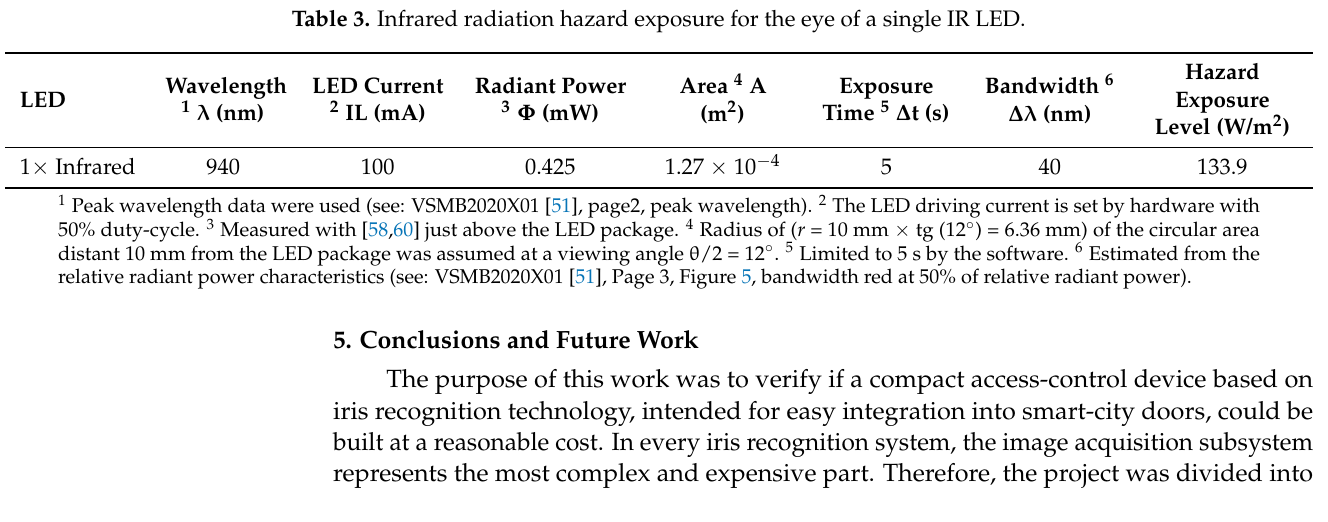
and under different illumination conditions: ( a ) no illumination (only the infrared distance measurement circuit is active), image sharpness = 136,000; ( b ) low RGB illumination level, image sharpness = 195,000; ( c ) high RGB illumination level, image sharpness = 229,000.